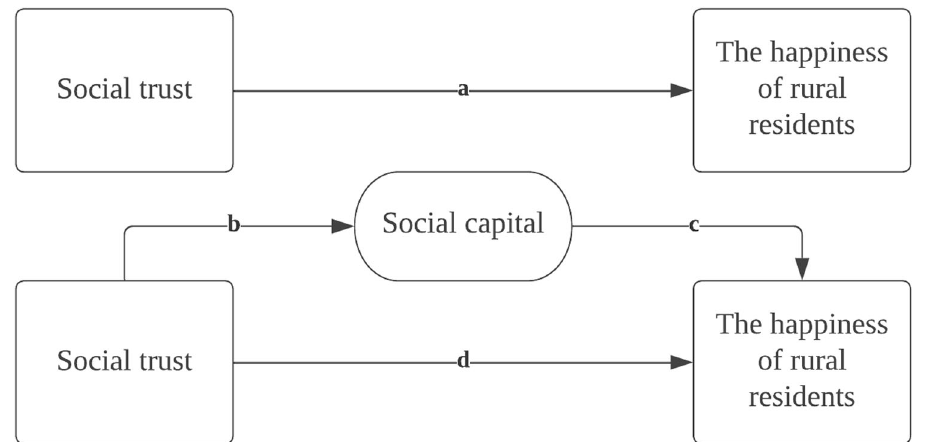
Fig. 1 Path diagram for the mediating effect of social capital. The research model shows the path analysis used to test the direct in fl uence of trust on the happiness of rural residents (path a) and social capital (path b), as well as testing the indirect in fl uence of trust on the happiness of rural residents via social capital (paths c and